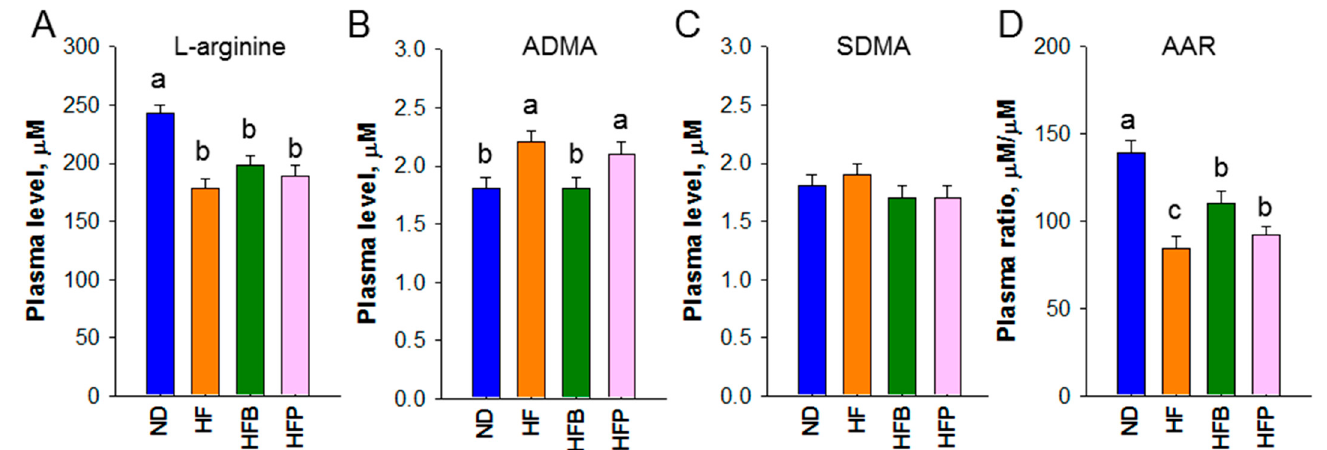
Figure 8. Plasma levels of ( A ) L-arginine, ( B ) asymmetric dimethylarginine (ADMA), ( C ) symmetric dimethylarginine (SDMA), and ( D ) L-arginine-to-ADMA ratio (AAR) of male o ff spring at age 12 weeks. N = 8/group; the le tt ers represent the di ff erences between the groups. Statistical analysis by one-way ANOVA, p < 0.05.